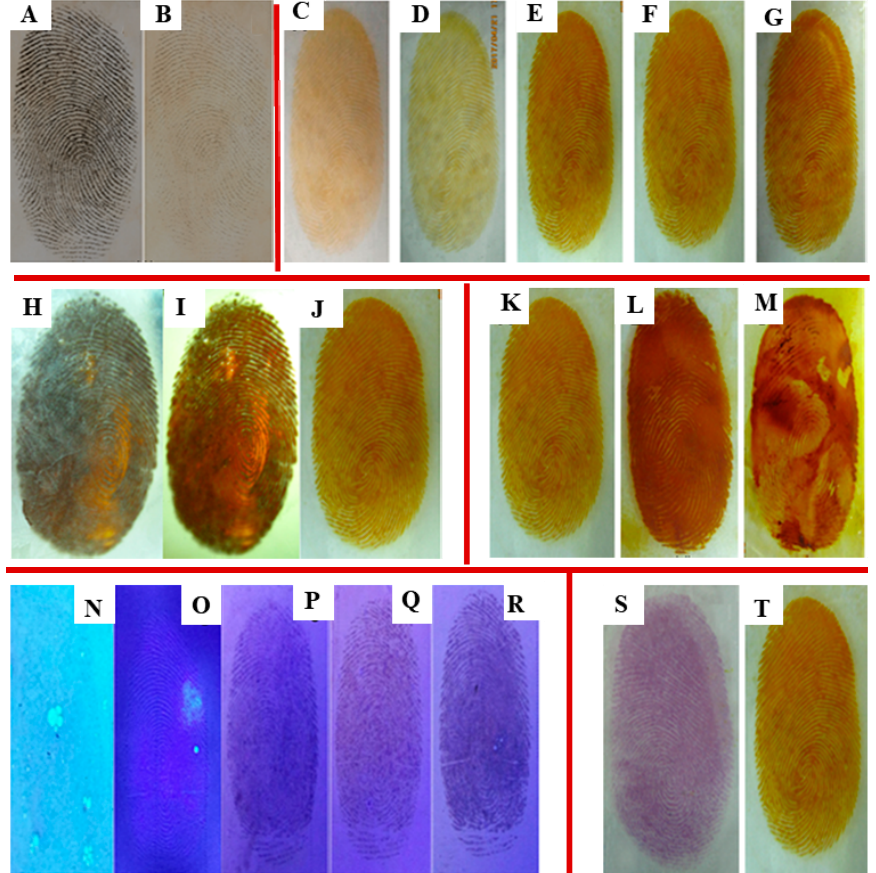
Figure 4. Fingerprint developing photos of CMCS/PVA composite hydrogel films under different external conditions: with excitation wavelengths of 254 nm ( A ) and 356 nm ( B ); at different irradiated times under 254 nm UV light: ( C ) 5 min, ( D ) 10 min, ( E ) 20 min, ( F ) 30 min, ( G ) 40 min; with different preparation methods: ( H ) frozen without irradiation, ( I ) refrigeration and irradiation, ( J ) short-term freezing and irradiation; with different coating modes: ( K ) spray, ( L ) smear, ( M ) soak; with different concentrations of Ag ions: ( N ) 0.12 mg/mL, ( O ) 0.6 mg/mL, ( P ) 1.2 mg/mL, ( Q ) 1.8 mg/mL, and ( R ) 2.4 mg/mL; with different developing reagents: ( S ) ninhydrin, ( T ) Ag ions.